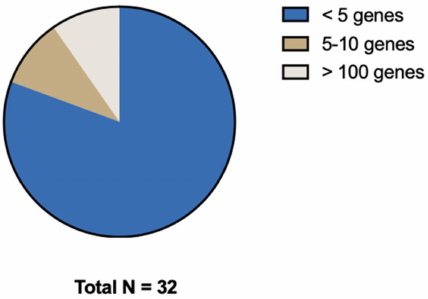
Figure 3. Distribution of number of genes investigated.